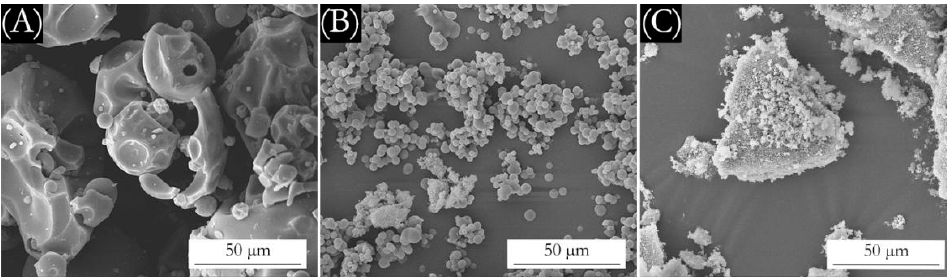
Figure 2. The microtopography: ( A ) the aloin, ( B ) the aloin microcapsules prepared with ethanol as the solvent, and ( C ) the aloin microcapsules prepared with water as the solvent.